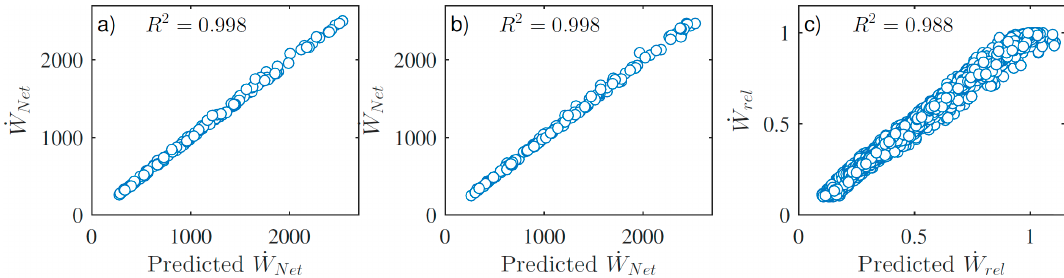
Figure 10. Predicted values against regression data: ( a ) design regression model #1, ( b ) design regression model #1, ( c ) off-design regression model.